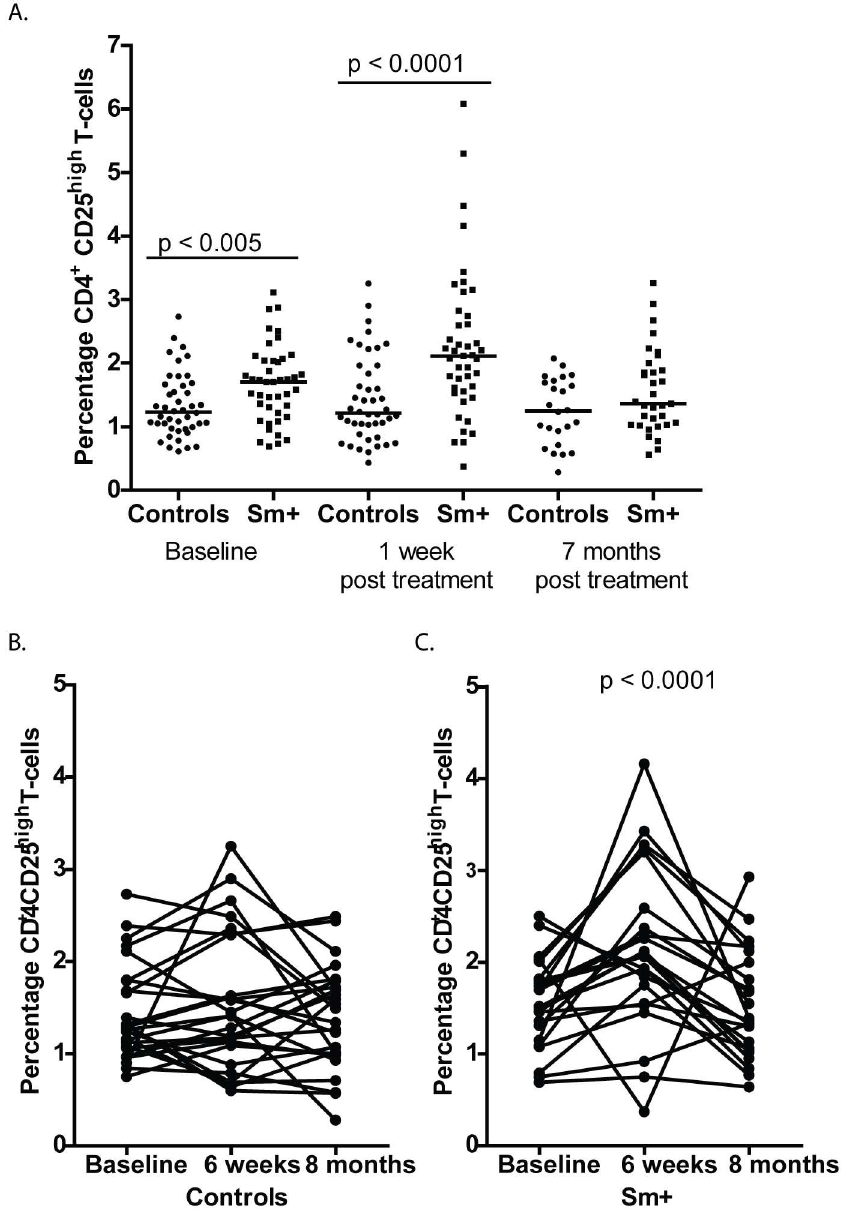
Fig 5. T regulatory cell (Treg) percentages (CD3 + CD4 + CD25 high cells) in peripheral blood are elevated in schistosomiasis infected individuals before praziquantel treatment and immediately following treatment. A. Whole blood was stainedwith anti-CD3-Alexa Fluor, anti-CD4-PercP and anti-CD25-PE and analyzedby flow cytometry at baseline, 1 week and 7 months followingpraziquanteltreatment of schistosomiasis infected individualsand uninfectedcontrols were followedat the same time points. CD25 expressionwas determined using a threshold based on florescenceminus one (FMO) controls and used for all analyseswith a CD25 high gate being set and used for all samples. Circles represent study controls, individuals at baselinenegativefor S . mansoni and Soil Transmitted Helminths, and squaresrepresent schistosomiasis positive at baseline.Bars represent medianTreg percentagesat each time point and statistical differencesat each time point were determined using the Mann-Whitney test with a p < 0.05 considered statisticallysignificant.B. Treg percentages in controls at baseline,7 weeks and 8 months did not changesignificantly over the study periodas determinedby the Friedman test followedby Dunn’smultiple comparisons. C. Treg percentagesin Sm+ individualsincreasedsignificantly at 7 weeks, 1 week following PZQ treatment, as compared to baselineand 8 months as determinedby the Friedman test followedby Dunn’smultiplecomparisons.